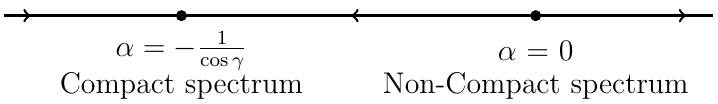
Figure 22 . RG flow from the Hamiltonian (3.19) to the Hamiltonian of [18], which correspond to a compact and a non-compact continuum limit